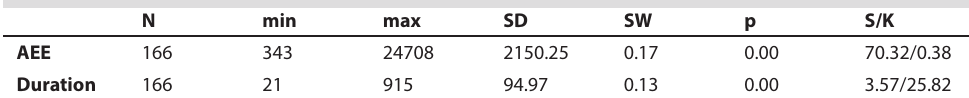
TABLE 2 PA descriptive statistics